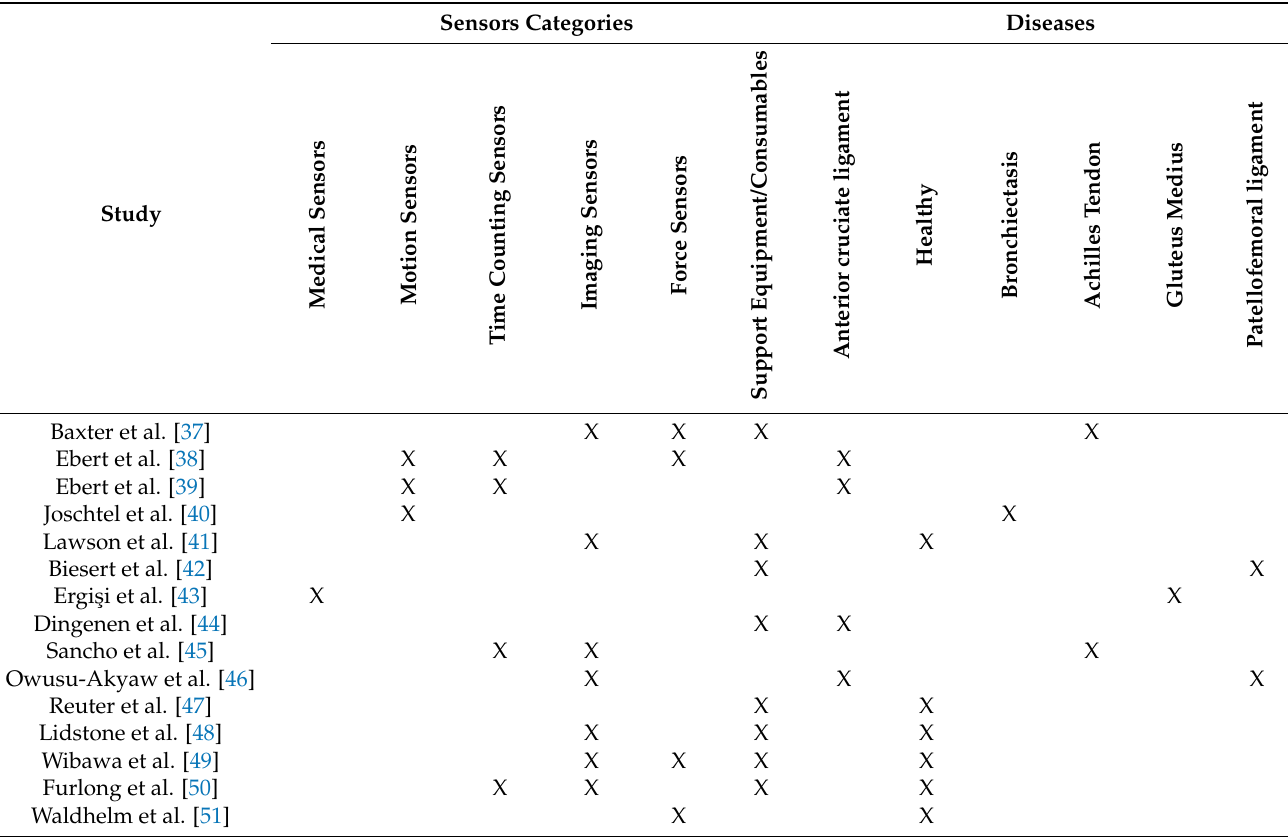
Table 3. Relation between diseases and sensors